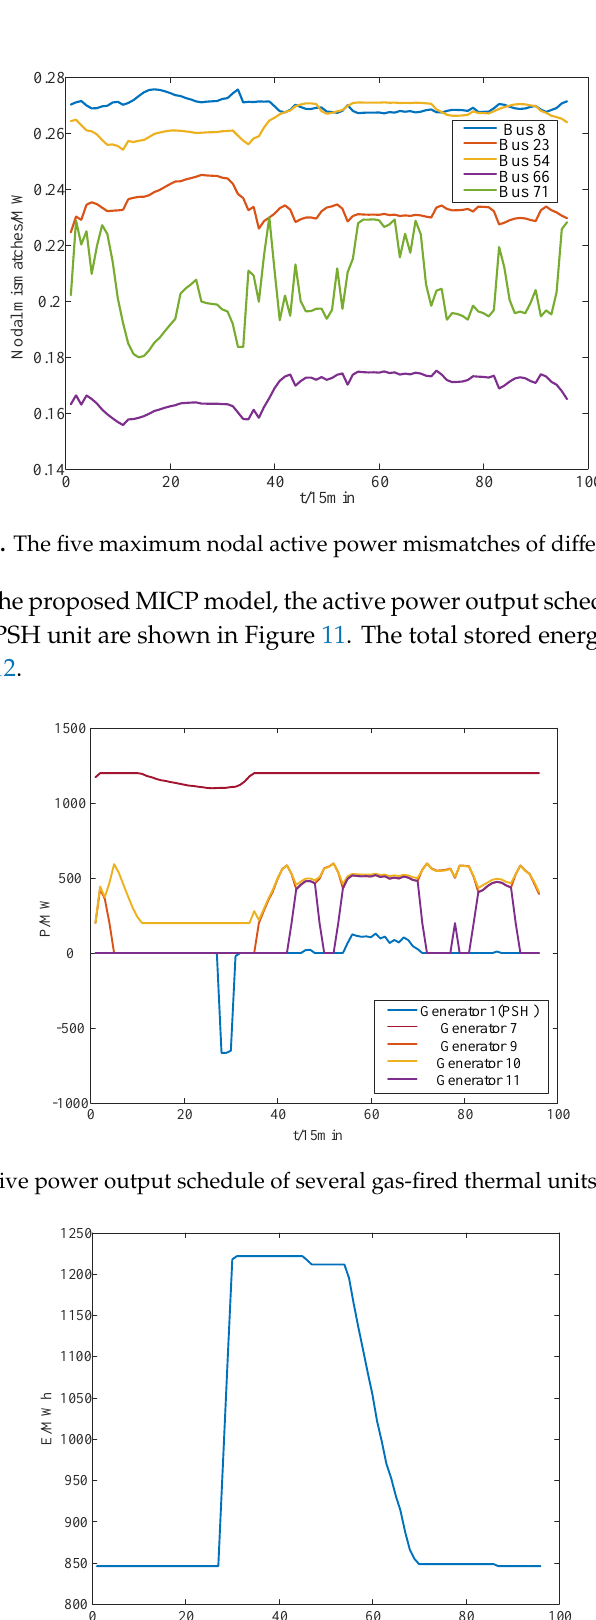
Figure 9. Absolute deviation between the values of the two sides of quadratic equality (25) on different lines.